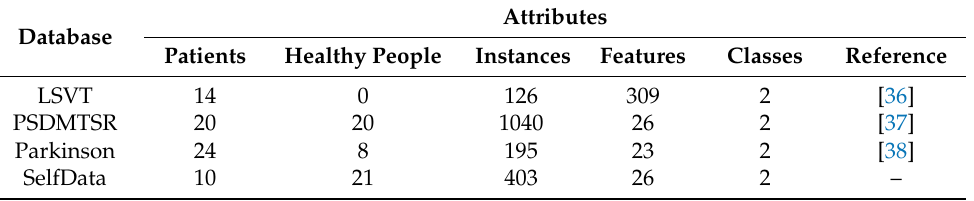
Table 1. Basic information about datasets.